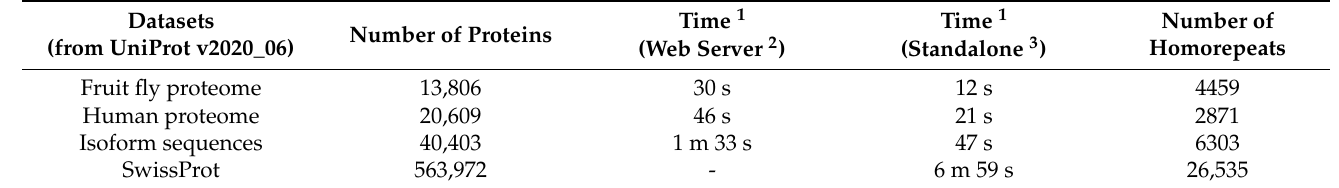
Table 1. Running time and number of homorepeats detected for several protein datasets and default parameters in the web server and using the standalone script.